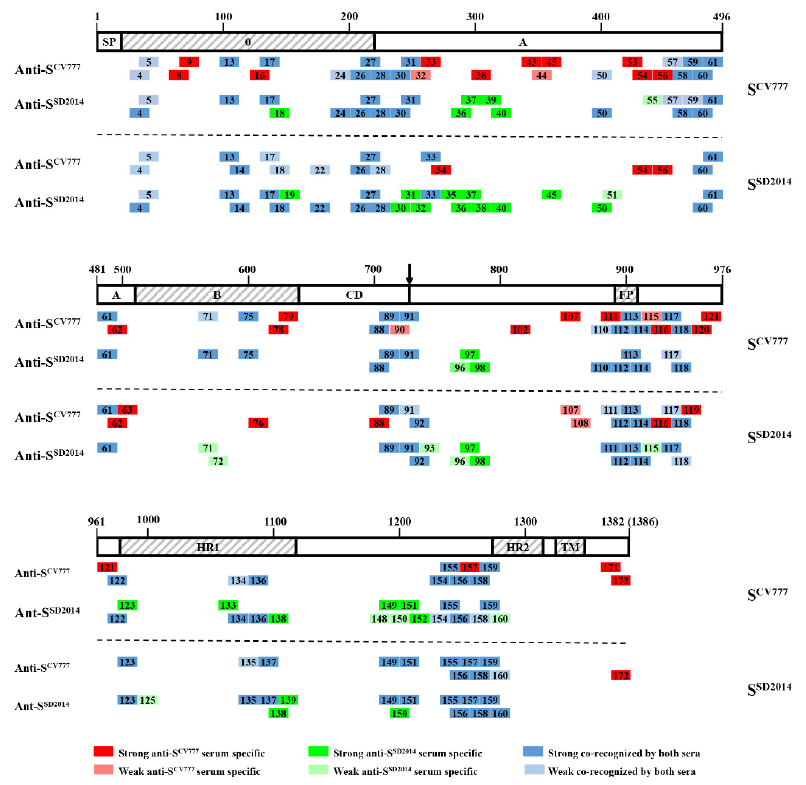
Figure 9. Comparative overview of positive 16-mers on S CV777 and S SD2014 . The horizontal bar represents the primary structure of the S protein, of which the functional domains are framed as Figure 1. Numbers shown above the long bar denote the beginning and end amino acids of the S protein of PEDV. The short rectangles are positive 16-mers of S CV777 or S SD2014 (except P172, which was a 14-mer on S CV777 ). Short rectangles filled with red color are anti- S CV777 serum-specific 16-mers. Short rectangles filled with green color are anti-S SD201 serum-specific 16-mers. Short rectangles filled with blue color are Co-RecoMers. Numbers assigned to the 16-mer peptides are the same as in Figure 5 or 7. The arrow show the boundary of S1/S2.